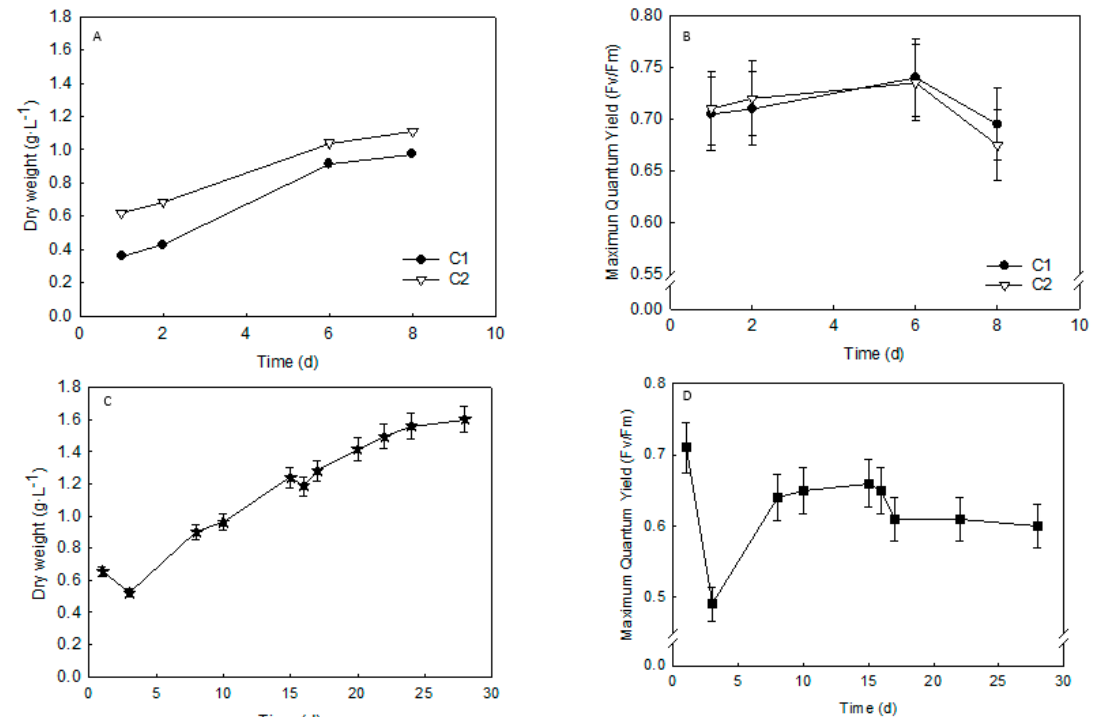
Figure 2. Growth of C. onubensis cultures in batch indoors and in an outdoor photobioreactor (PBR) system. Time-course evolution of growth in batch cultures ( A ) and photosynthetic capacity (maximum quantum yield, ( B )). Time course of growth in an outdoor PBR ( C ). Photosynthetic capacity in photobioreactor culture ( D ). Two conditions of initial biomass concentration were assessed: 0.31 g L − 1 (C1) and 0.57 g L − 1 (C2). Details of the experimental set-up and parameter determination are described in Section